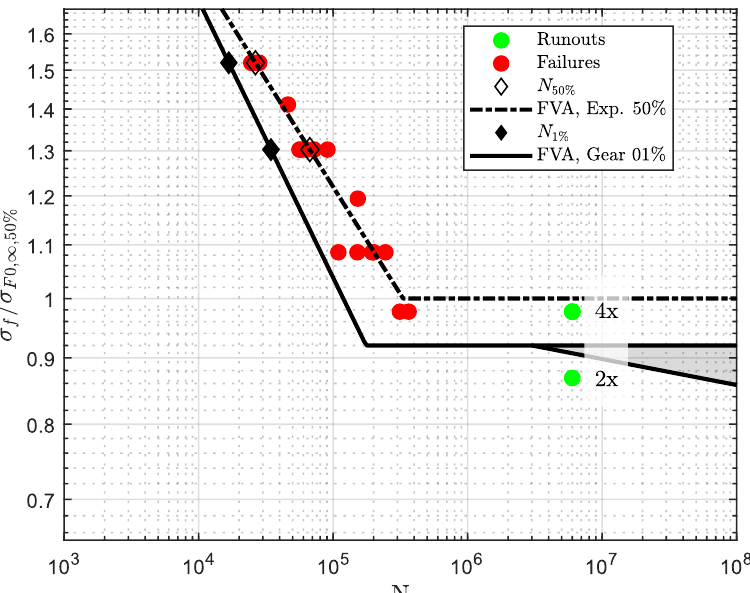
Figure 7. Evaluation of SN curves with different failure probabilities for exemplary campaign A from the experimental FZG database [24] according to FVA guideline 563 I [25].